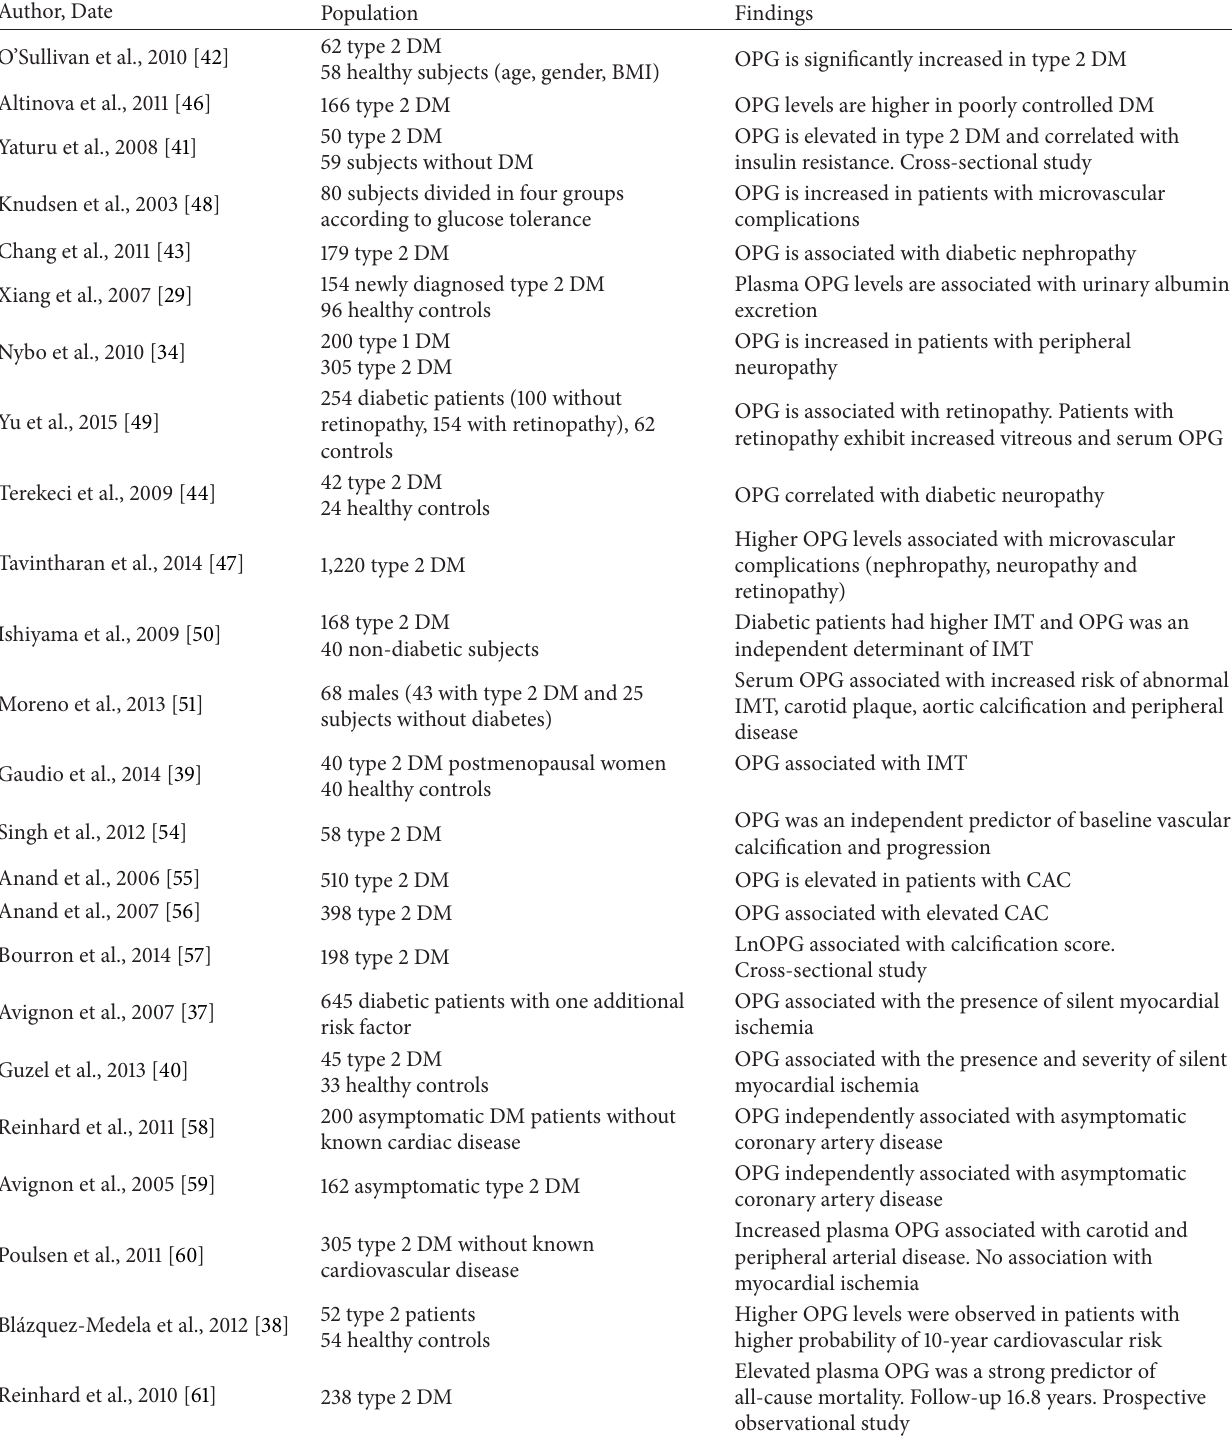
Table 3: Studies assessing the association between osteoprotegerin and diabetes mellitus type